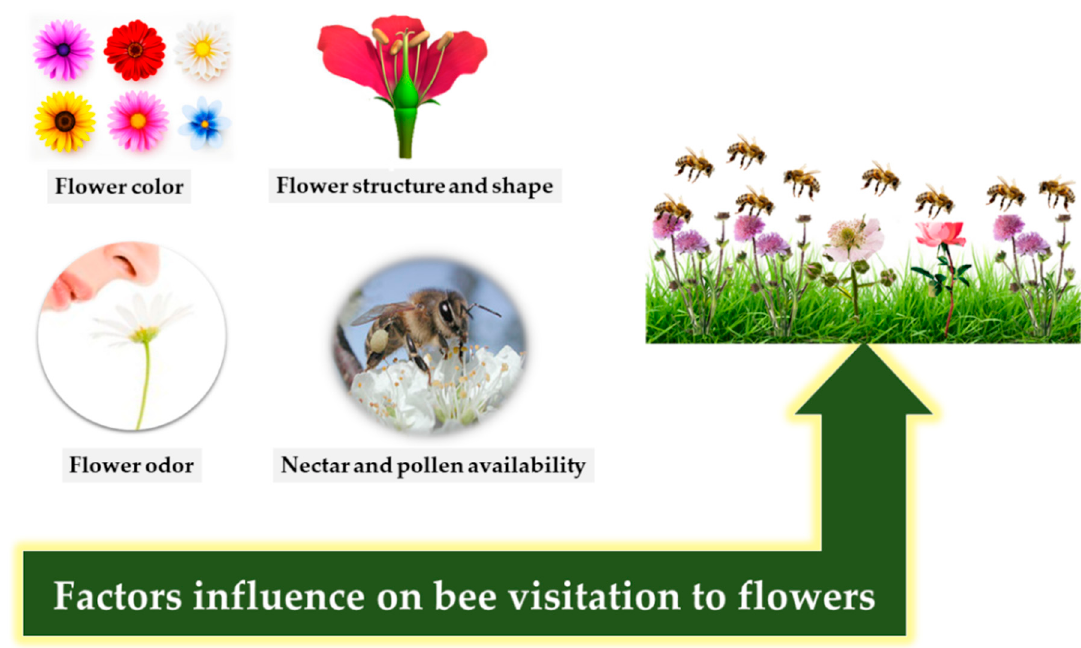
Figure 1. Factors that influence bee visitation.